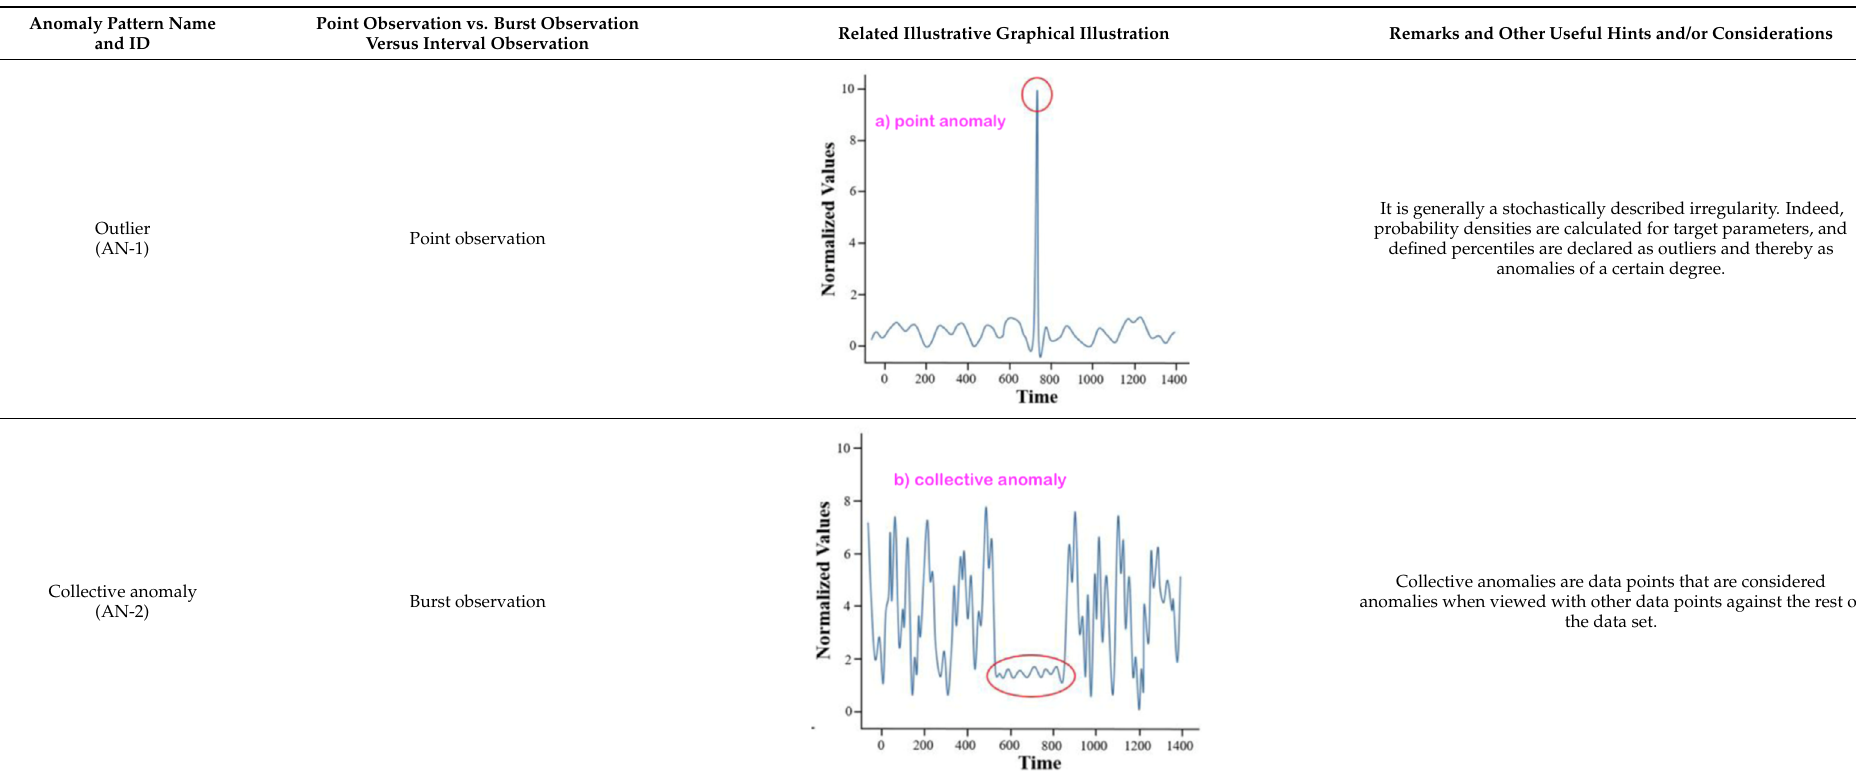
Table 1. Overview of all anomaly patterns that may be observed/detected w.r.t. a given simple or global attribute of an entity belonging to any of the four highest levels of the data-processing hierarchy of Figure 3.